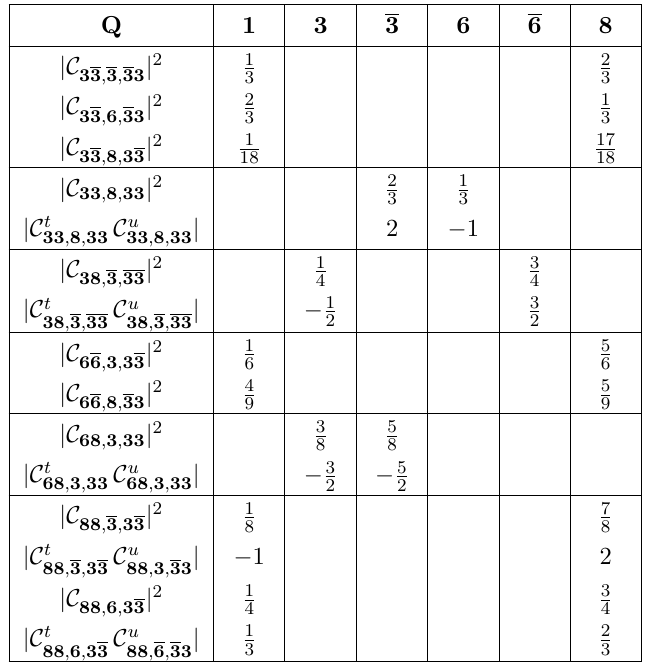
Table 4 . Clebsch-Gordan coe(cid:14)cients (cid:12) Q , described in equation (B.5), corresponding to the di(cid:11)erent possible SU (3) eigenstates of the initial states for t and u -channel X annihilation (last diagram in (cid:12)gure 3 and the last two diagrams in (cid:12)gure 4). The con(cid:12)gurations already present in table 3 have been omitted